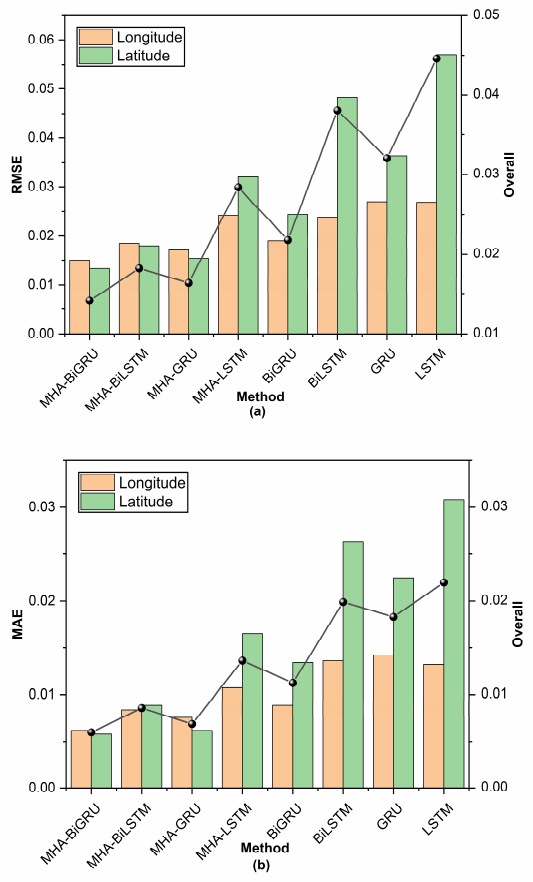
Figure 11. RMSE and MAE value comparison among all models: ( a ) RMSE ( b ) MAE.